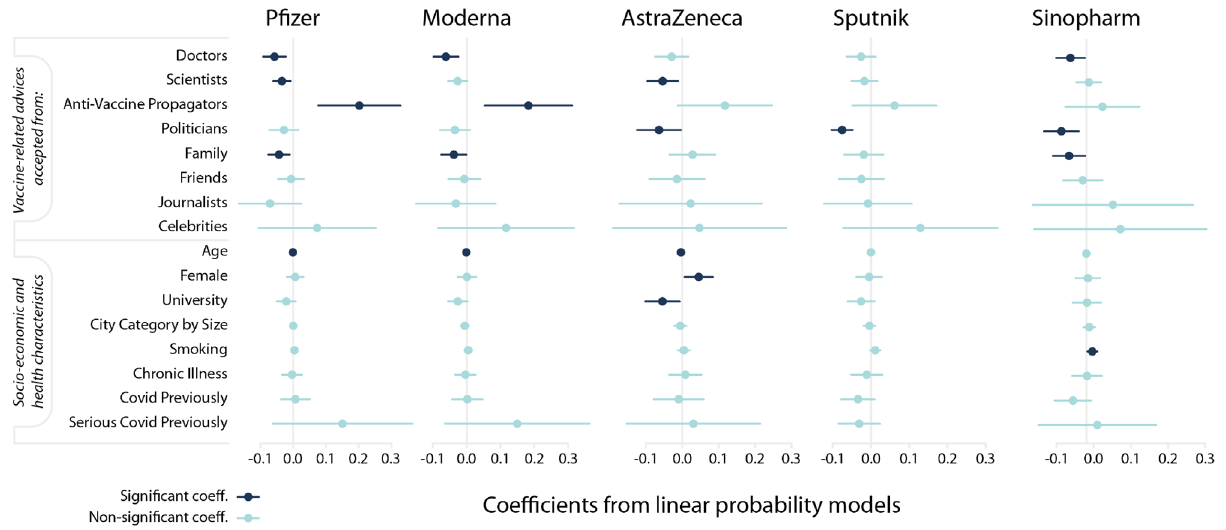
Figure 3. Source of advice taken characterize hesitancy against vaccines differently. Estimation results from linear probability models with robust standard errors. The dependent variable equals 1 if the respondent evaluates a vaccine type unacceptable and 0 otherwise. Markers denote point estimates and 95% confidence intervals are denoted by the bars. Non-significant coefficients are in light blue ( p ≥ 0.05 ); significant coefficients are in dark-blue ( p < 0.05